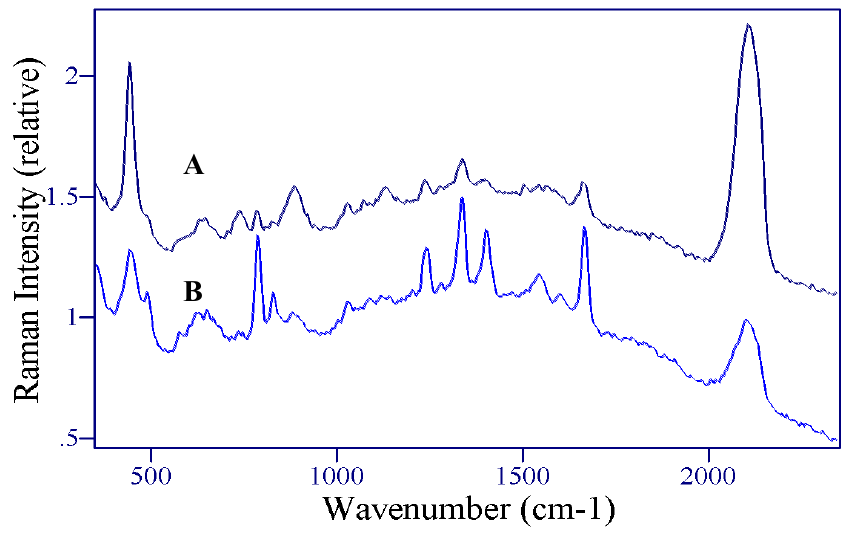
Figure 11. Surface-enhanced Raman spectra of 5FU in A) saliva and B) 1:3 saliva:water. Conditions: 1 mg/mL, 100 mW of 785 nm, 1 min. Same initial saliva sample and intensity scale.